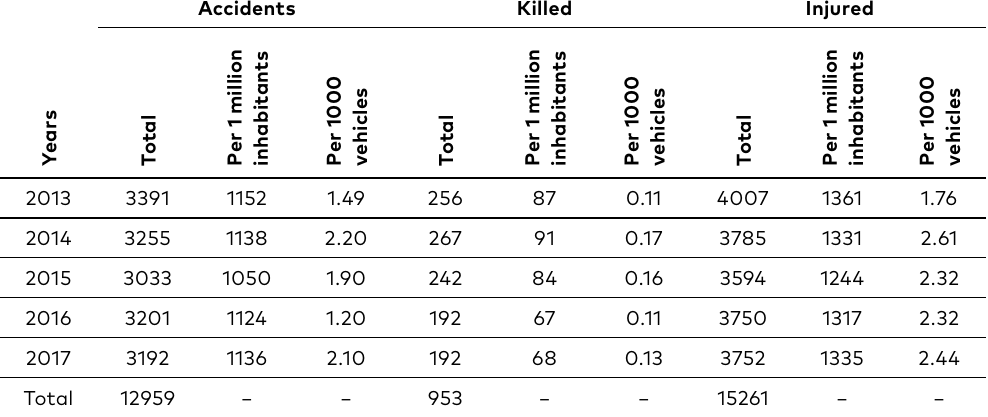
Table 1. Accidents and their victims in